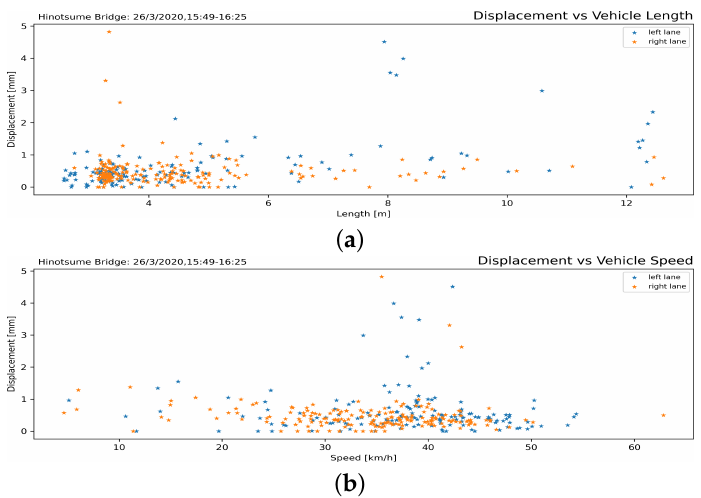
Figure 13. Bridge displacement according to vehicle lengths ( a ) and speeds ( b ). Most passes resulted in displacement less than 1 mm. The vehicle needed to travel at substantial speed to induce substantial structural displacement on the bridge. Several small vehicles were cross-recorded having large displacement due to crossing the bridge at the same time as a large vehicle.